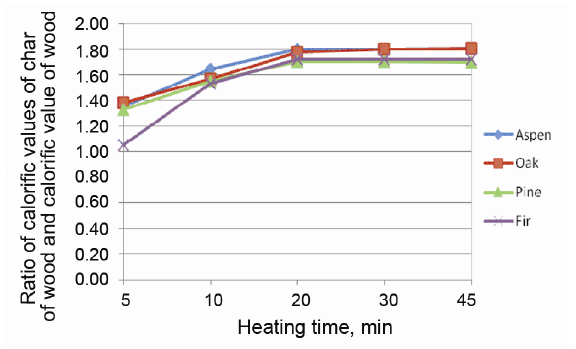
Fig. 14. Ratio of calorific values of char resulting from different species of wood and calorific value of